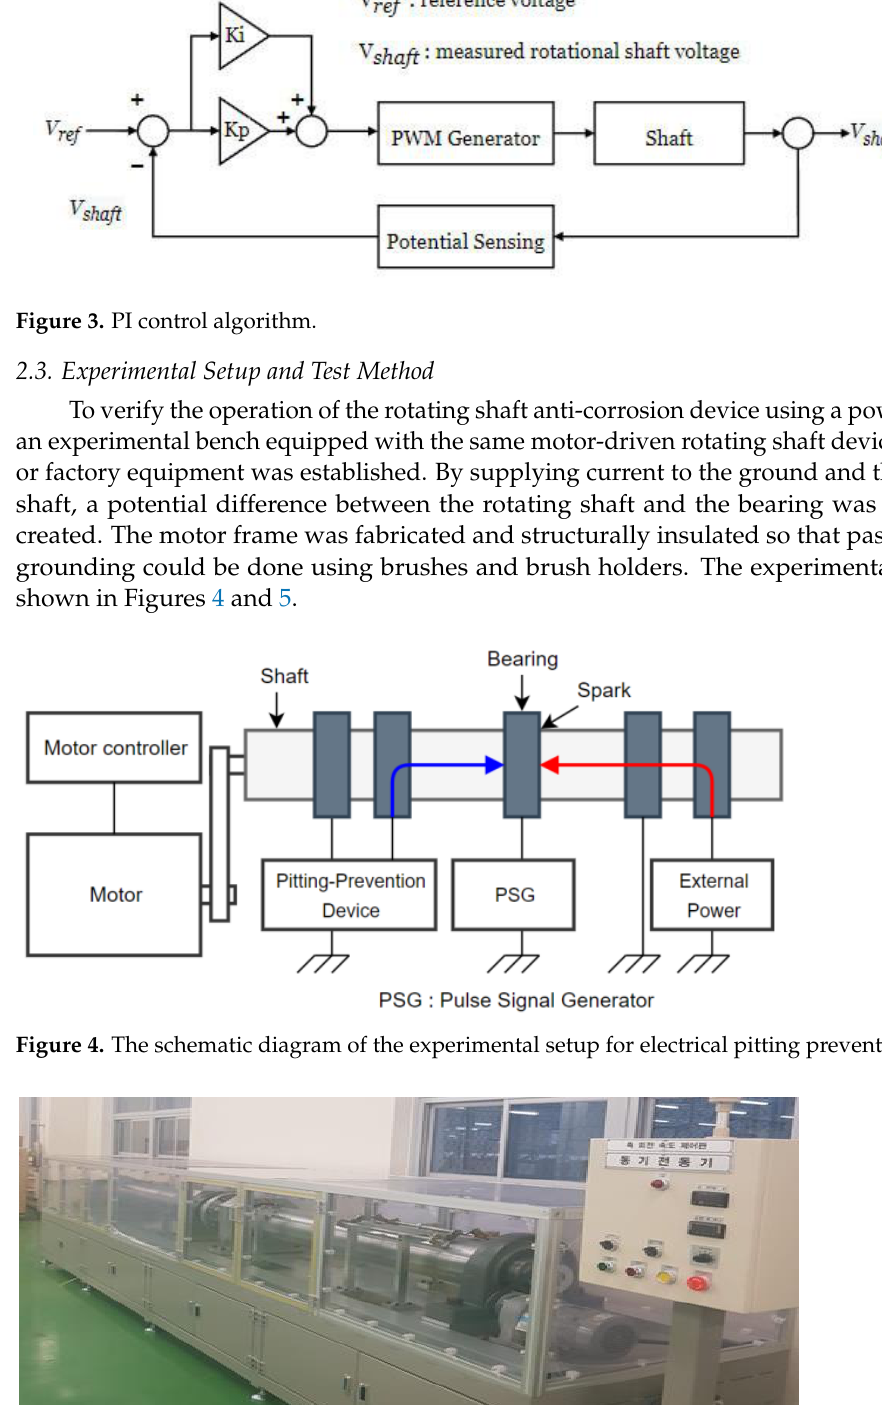
Figure 4. The schematic diagram of the experimental setup for electrical pitting prevention device.